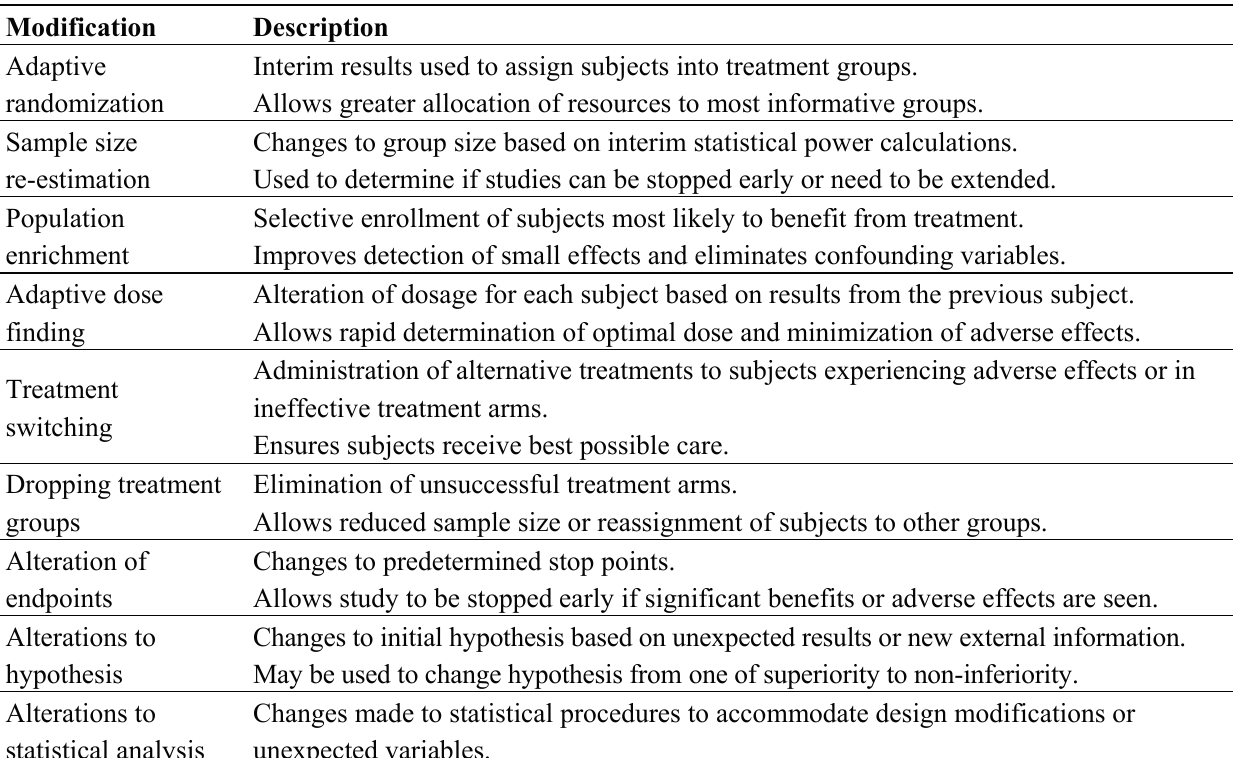
Table 1. Modifications used in adaptive design